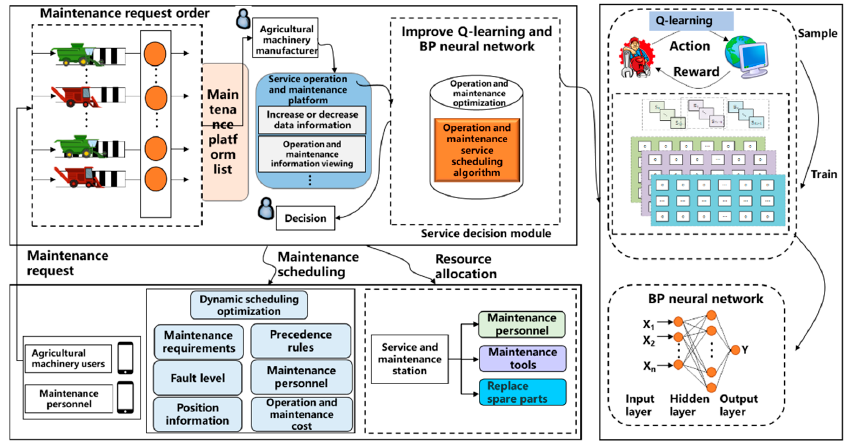
Figure 2. The overall framework of the dynamic algorithm.